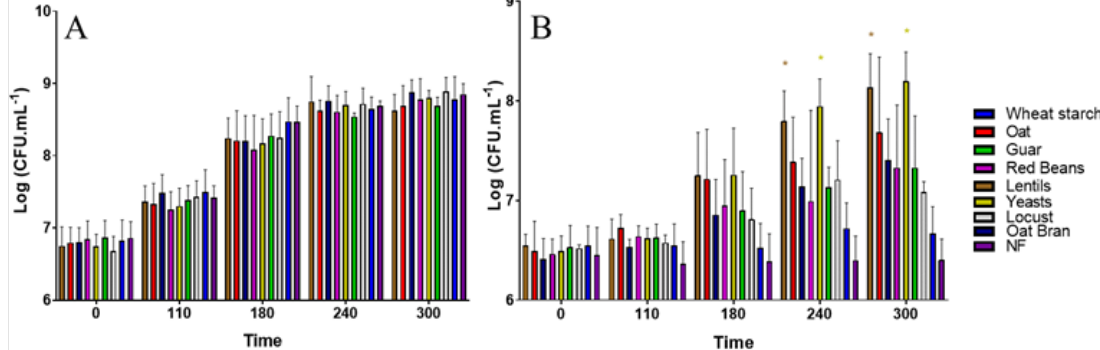
Figure 1. Effect of fiber-containing products on the time course of ETEC strain H10407 bacterial growth in complete LB medium ( A ) or in M9 minimal medium ( B ). Fiber-containing products were tested at 2 g·L −1 of final fiber content. Each bar represents the mean of three biological independent replicates (±SD). Results are expressed as mean log10 CFU·mL −1 . Significance with the control condition was determined by Dunnett’s multiple comparisons test (*: p < 0.05). NF=control condition with no product added, SD = standard deviation.